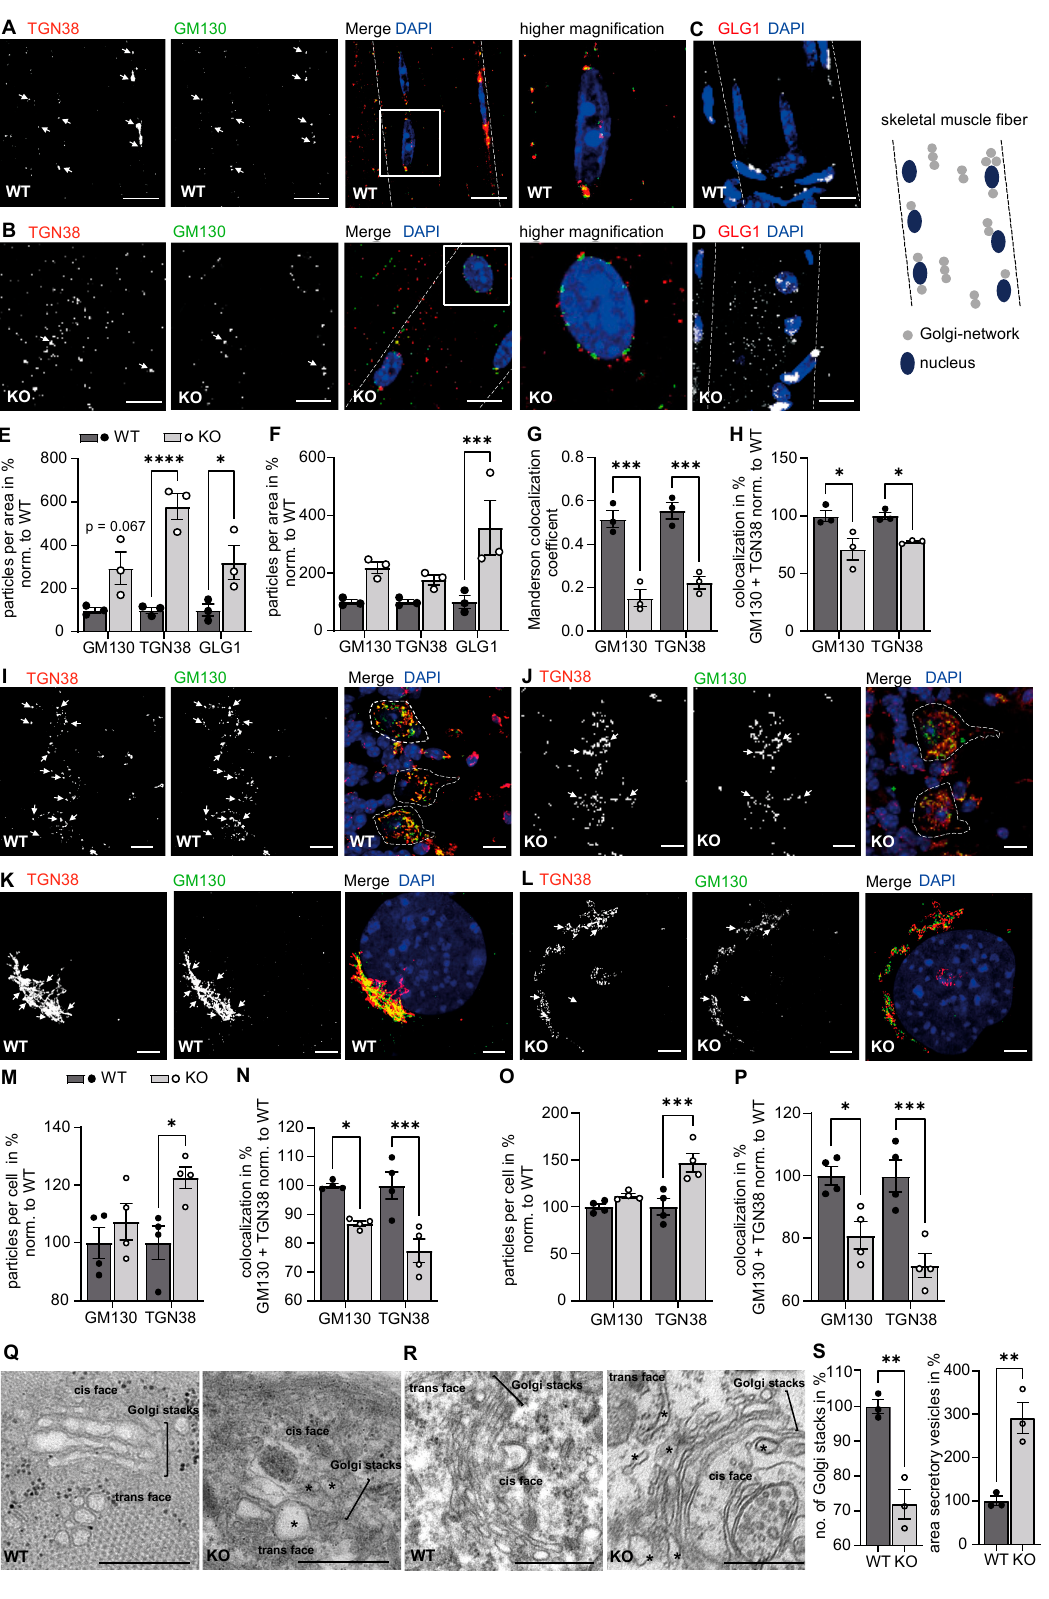
Figure 1. Loss of GMPPA alters the morphology of the Golgi apparatus in skeletal muscle fibers and in neuronal cells. ( A , B) Representative images of skeletal muscle fibers from 5-month-old mice stained for TGN38 and GM130 (scale bar: 10 µ m). ( A ) WT fibers show a Golgi signal with